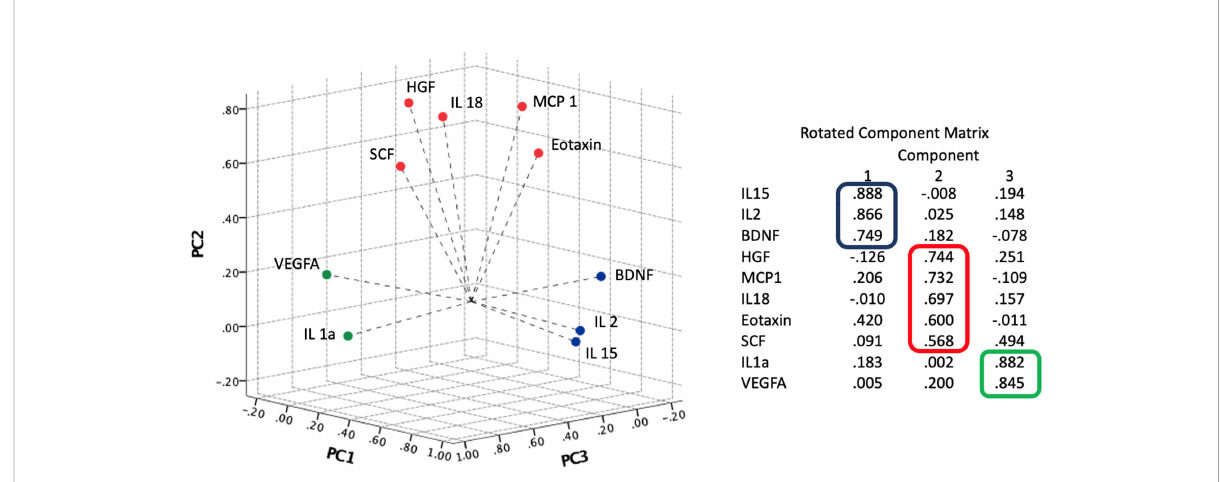
FIGURE 1 Component plot in rotated space. Results of principal component analysis (PCA) and Varimax rotation method with Kaiser normalization. The three components accounted for 66.09% of the total